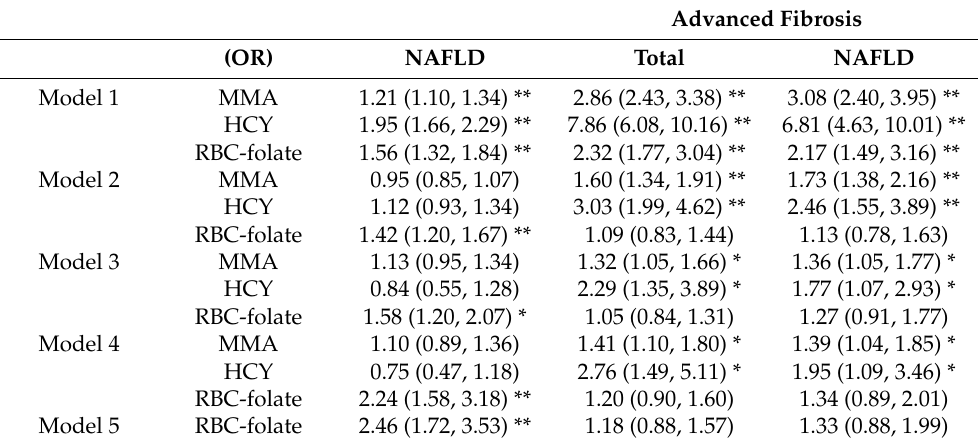
Table 2. The association of MMA, HCY, and RBC-folate with NAFLD or advanced fibrosis in participants from NHANES